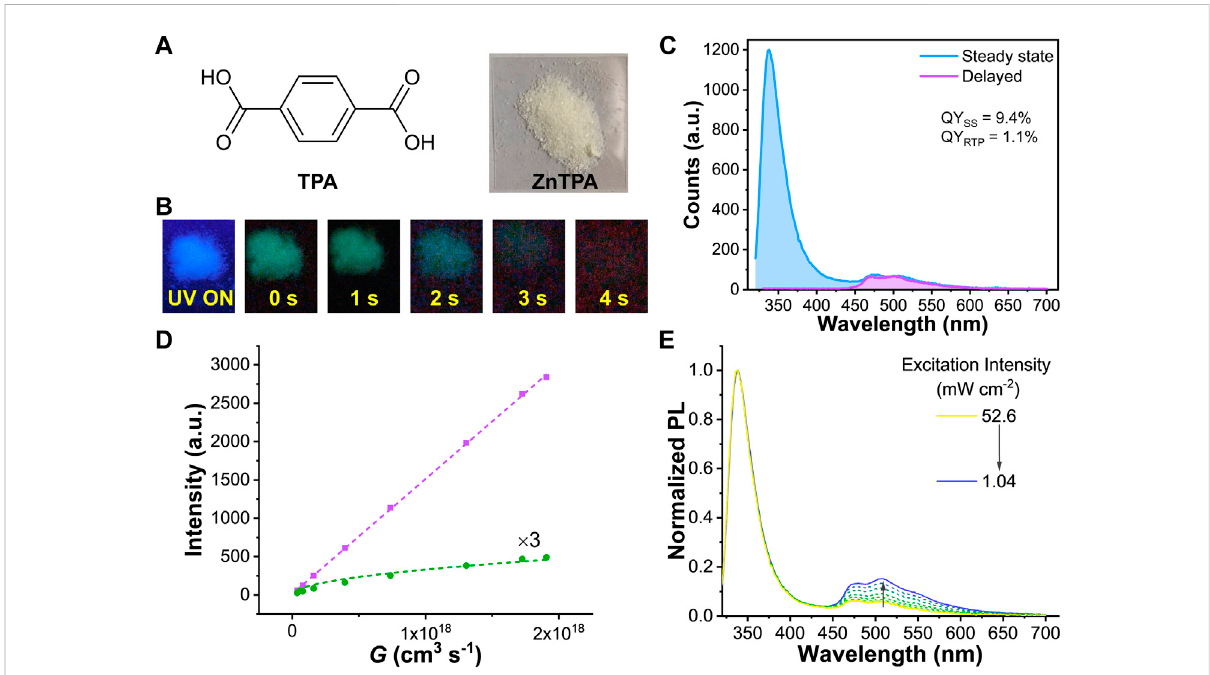
FIGURE 4 (A) Chemical structure of terephthalic acid (TPA) and photograph of ZnTPA MOF (B) Photographs of ZnTPA under and after excitation of UV (365 nm)light (C) Steady-statePLanddelayedRTPspectraofZnTPA.Theblue-andpurple-colored fi llingsrepresenttheintegratingareasofsteady- state PL and delayed RTP, respectively. For steady-state PL and QY SS , the excitation power is 52.6 mW cm − 2 (D) Power dependent PL intensities are monitored at 338 (purplesquare) and 509 (green rhombus) nm. Purple dash line is obtained from a linear fi t while green dash line results from